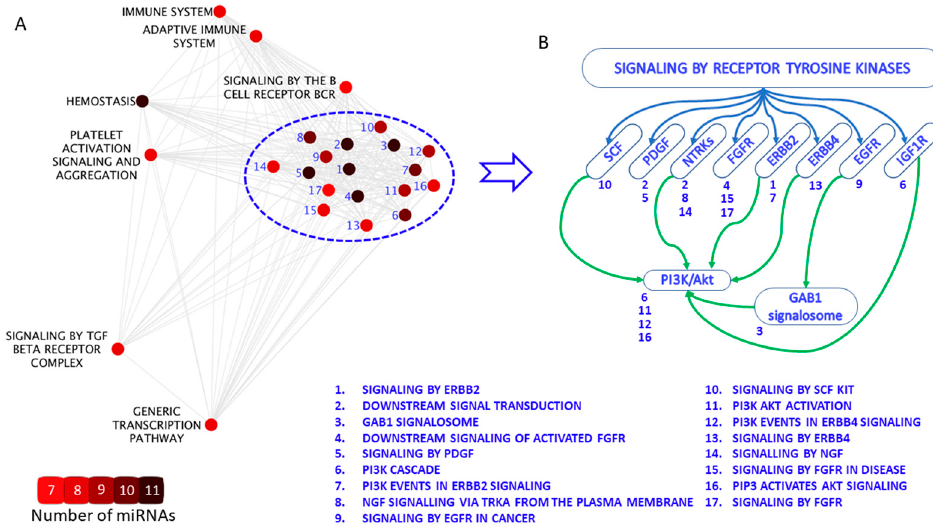
Figure 4. Network-based enrichment analysis of genes targeted by miRNAs differentially expressed from DLK1-DIO3 locus in male relapsing-remitting multiple sclerosis patients, according to next generation sequencing (NGS) data. ( A ). Network of overlaps for Reactome signaling pathways that significantly enriched with genes targeted by differentially expressed miRNAs (Fisher p -value < 0.05). Blue numbering indicates 17 pathways, activated through receptor tyrosine kinases (they are listed in the figure). The color of the nodes represents number of miRNAs, regulating the pathway (ranging from 7 to 11 miRNAs). The more common target genes are shared between two signaling pathways, the closer they placed to each other on the figure. ( B ). The assembly of receptor tyrosine kinase-activated pathways, regulated by identified differentially expressed miRNAs, based on Reactome